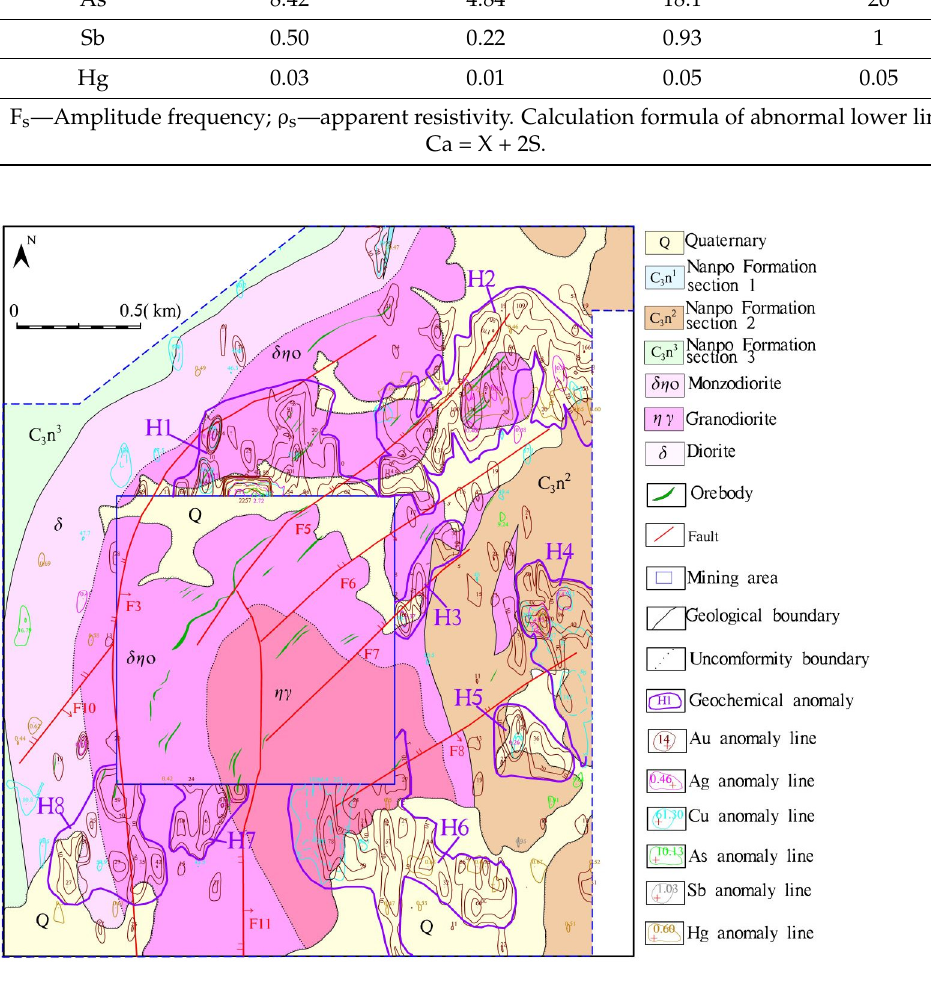
Table 2. The lower limit of the soil geochemical investigation in the Nanpo gold deposit.